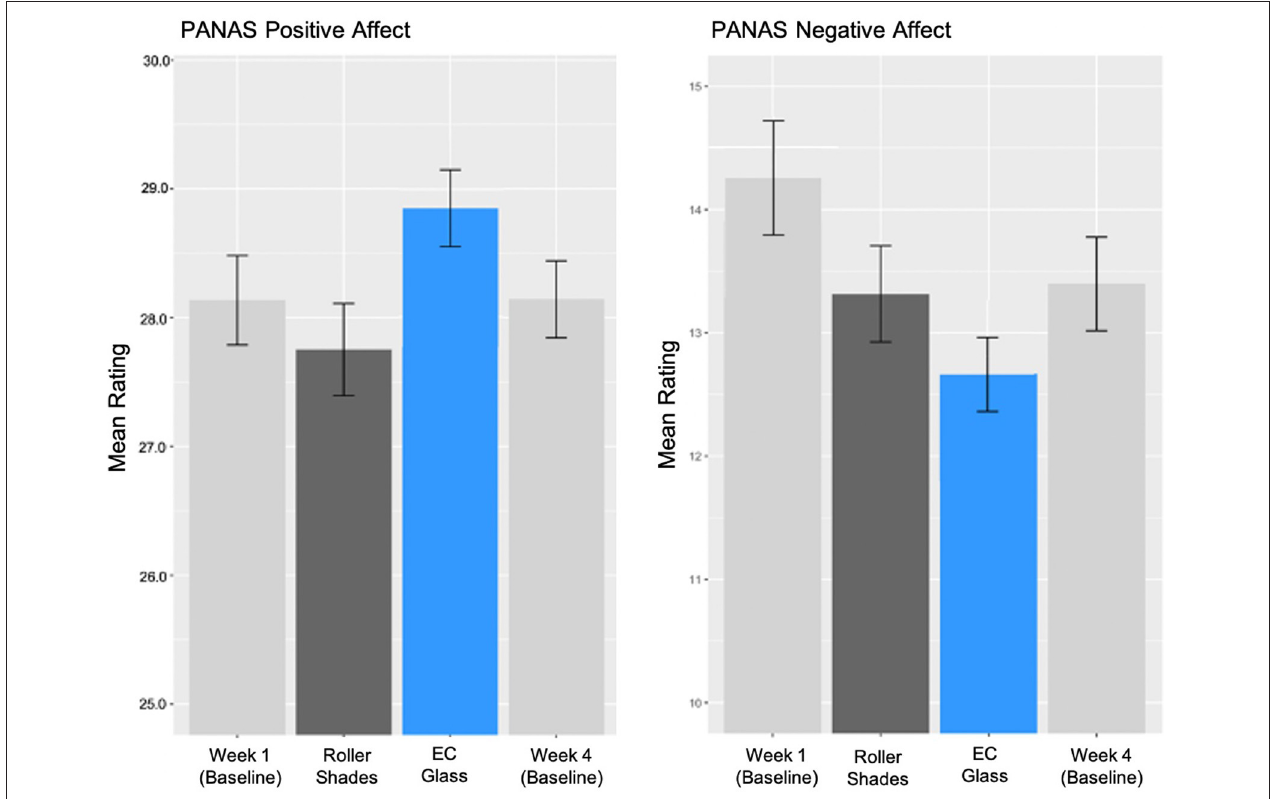
FIGURE 5 | Mean positive and negative affect scores in across the four study weeks. TABLE 5 | Factor analysis of the 20 items in the PANAS scales.